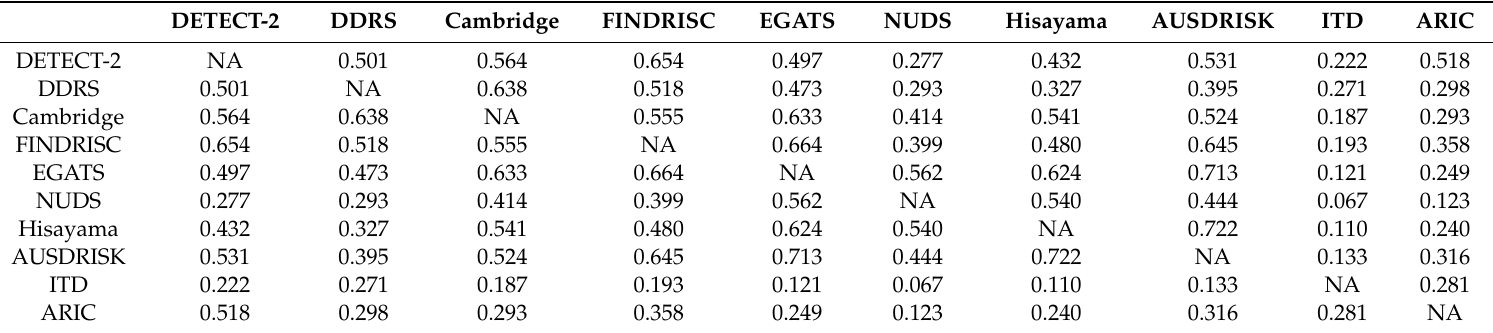
Table 5. Agreement (kappa) between risk predicted (high and non-high risk) by DETECT-2, DDRS, FINDRISC, EGATS, and NUDS scores. DETECT-2 DDRS